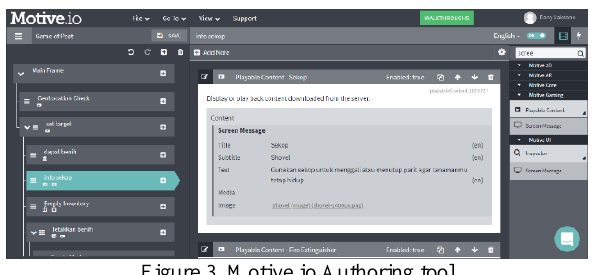
Figure 3. Motive.io Authoring